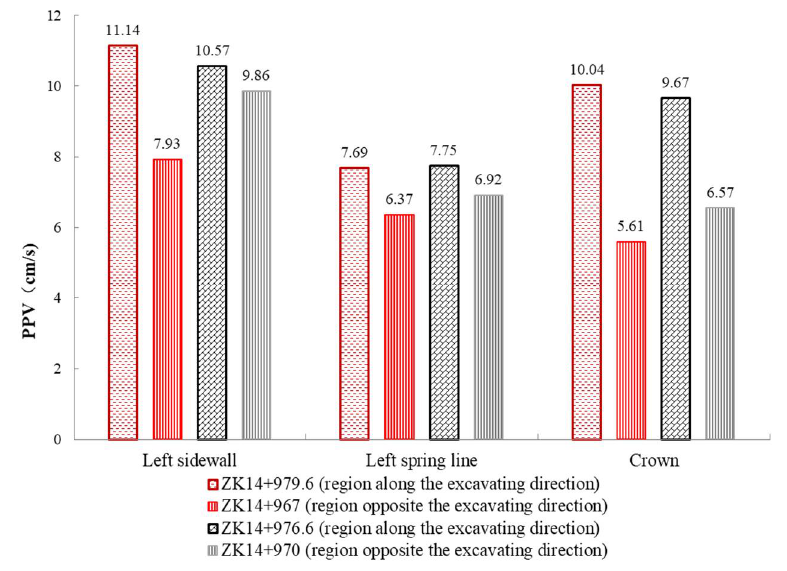
Figure 11. Comparison of the particle velocities measured at YK14 + 976 as the vibration waves from four blasts propagated through regions along the excavating direction and opposite to the excavating